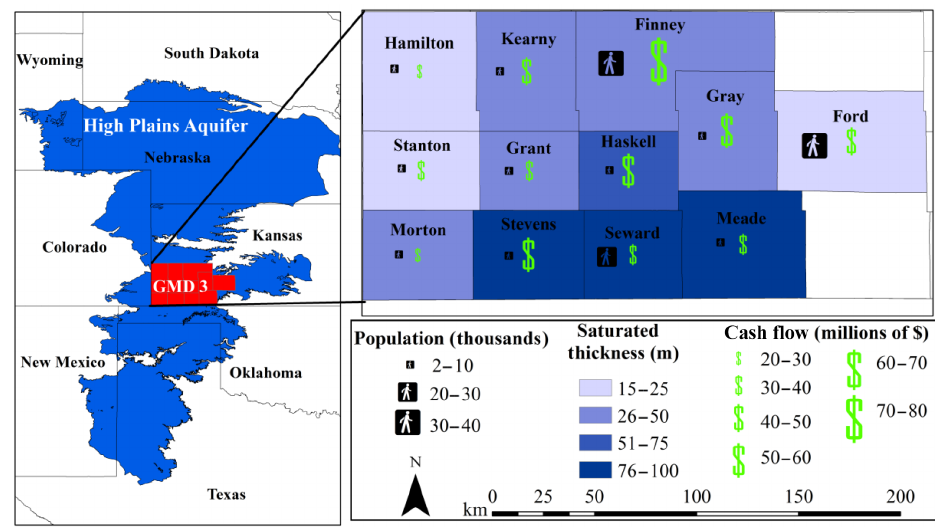
Figure 1. The groundwater, population, and cash flow summary statistics for the 12 counties of Groundwater Management District 3. Created by Weston